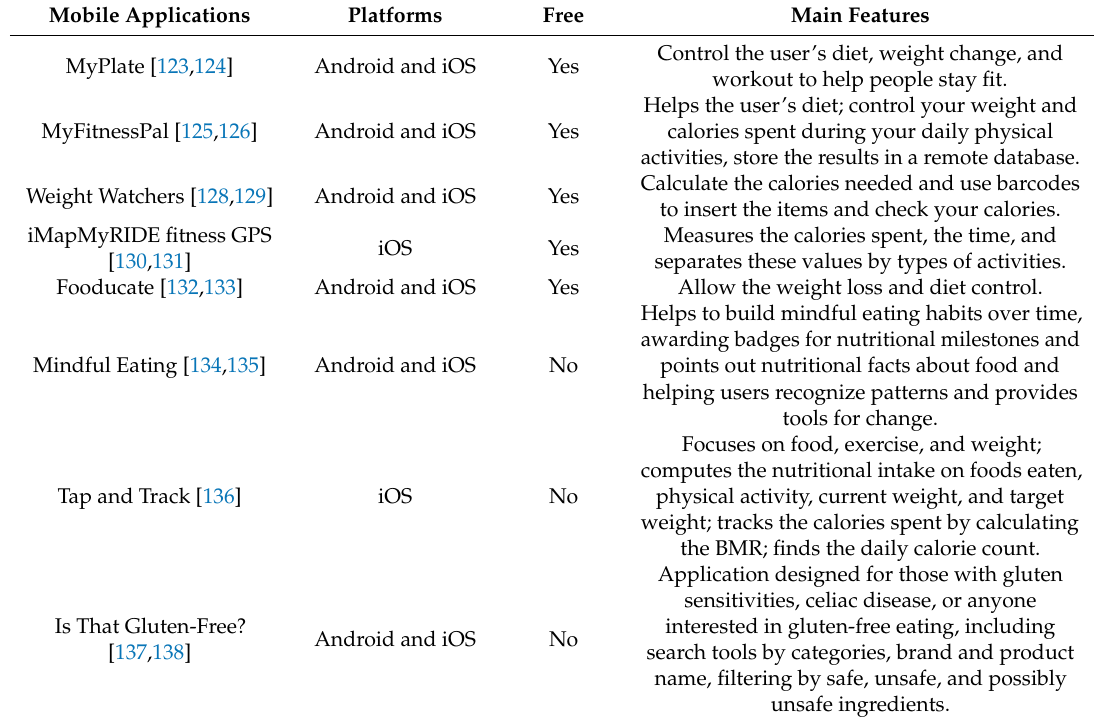
Table 3. Mobile health applications related to personal care